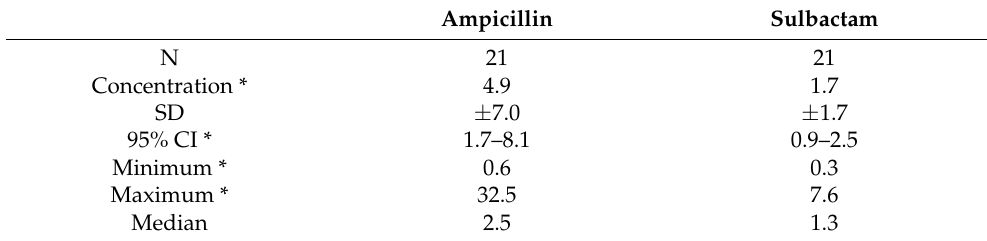
Table 4. Concentrations of ampicillin and sulbactam in necrotic bone